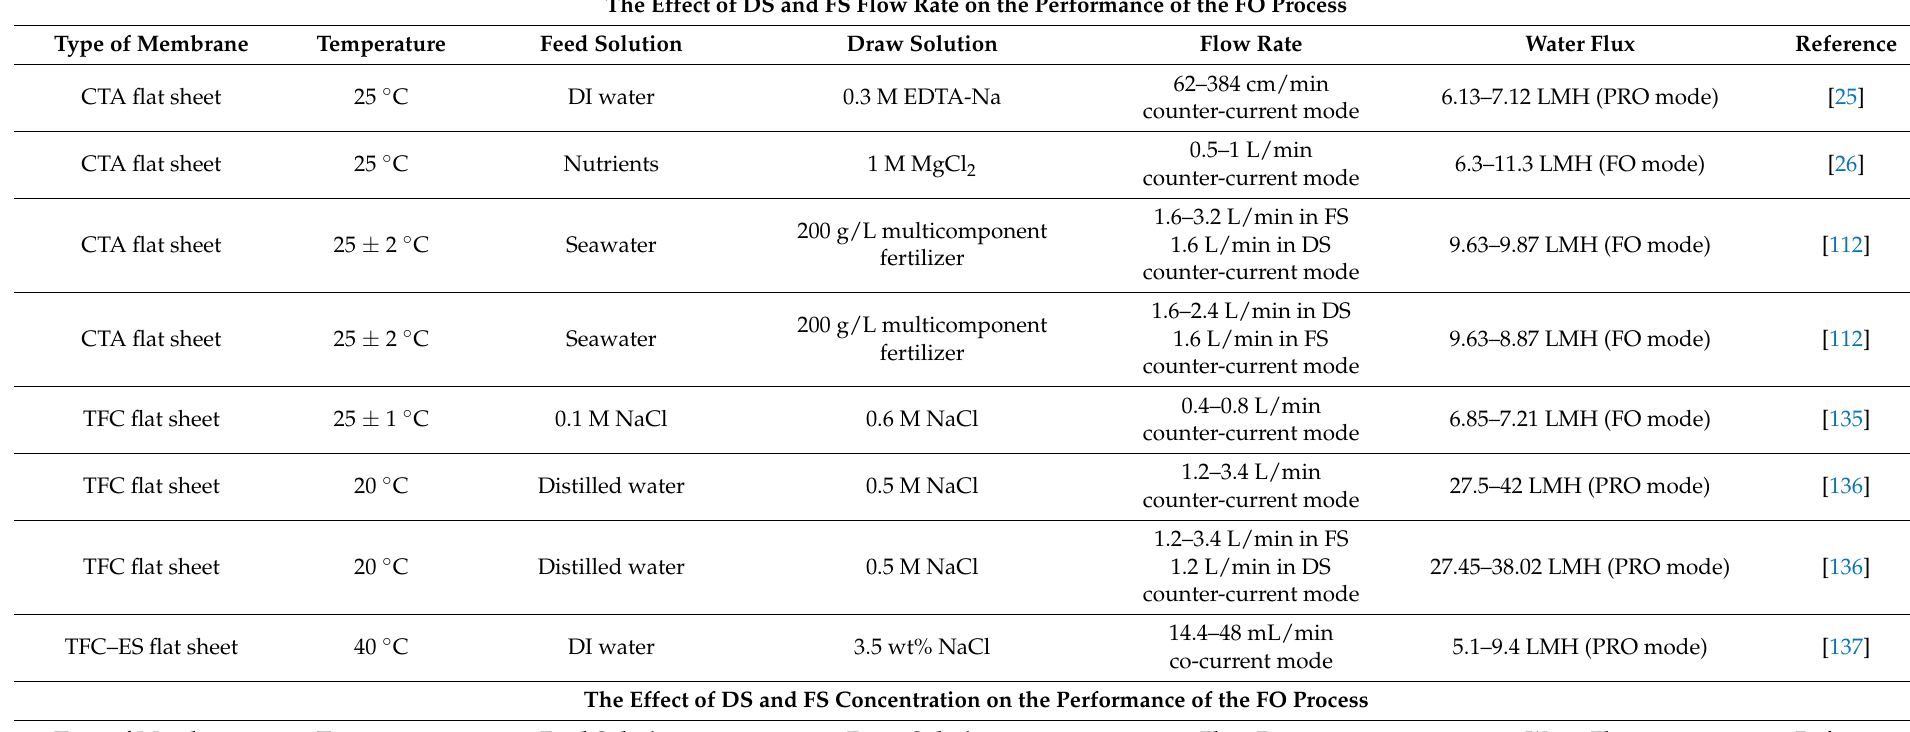
Table 3. Effect of operating conditions on FO performance in the literature. The Effect of DS and FS Flow Rate on the Performance of the FO